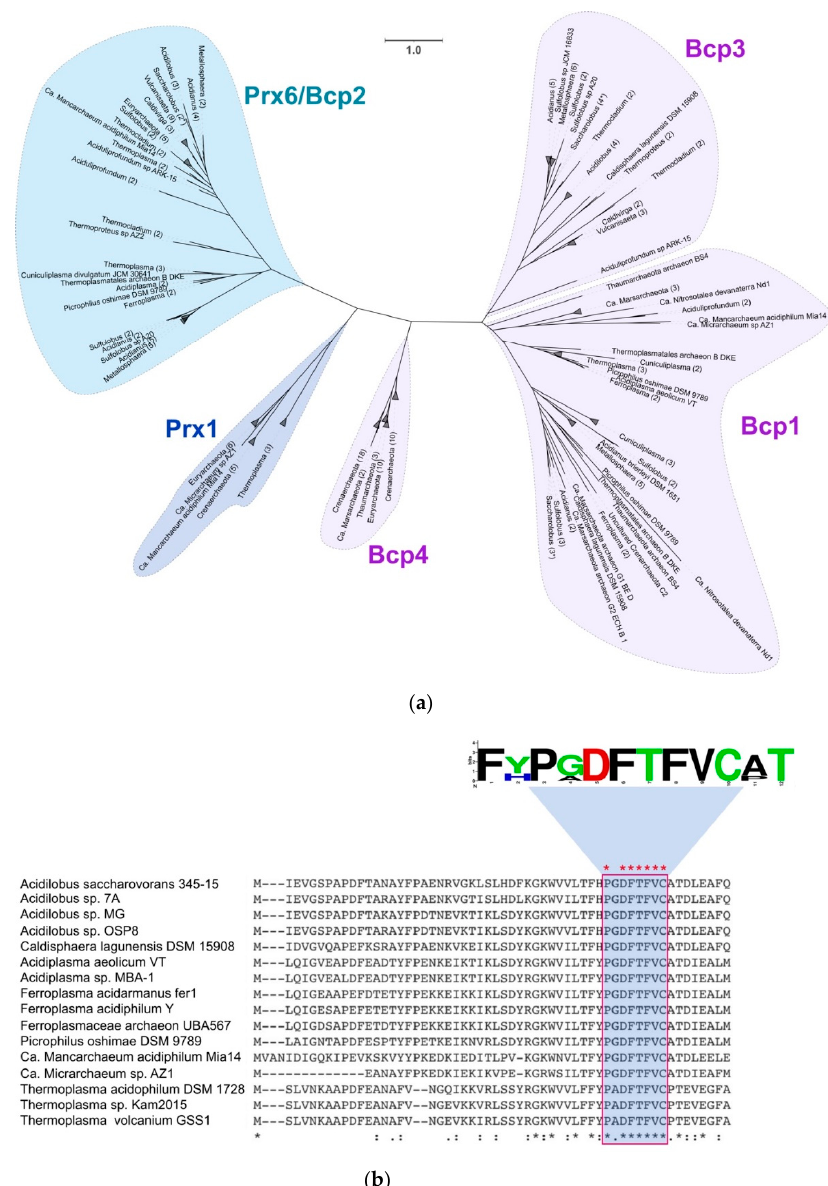
Figure 5. Peroxiredoxin (Prx) family proteins identified across acidophilic archaea. ( a ) Phylogenetic tree of all identified Prx sequences. Branches are collapsed to phyla or genus level when possible (if not, only the names are grouped), with the number of sequences that formed the clade in parentheses (the * indicates Saccharolobus with Sulfolobus collapsed together). In purple are the sequences from PrxQ type (Bcp1-3-4 like), in blue Prx6 type (Bcp2) and in darker blue Prx1. Scale bar represents 1 amino acid substitution per site. ( b ) Multiple sequence alignment of the Prx1 sequences (N-terminal extract showed). Conserved motifs associated with the characterization of Prx1 are marked in blue and shown in LOGOS graphic in the upper right